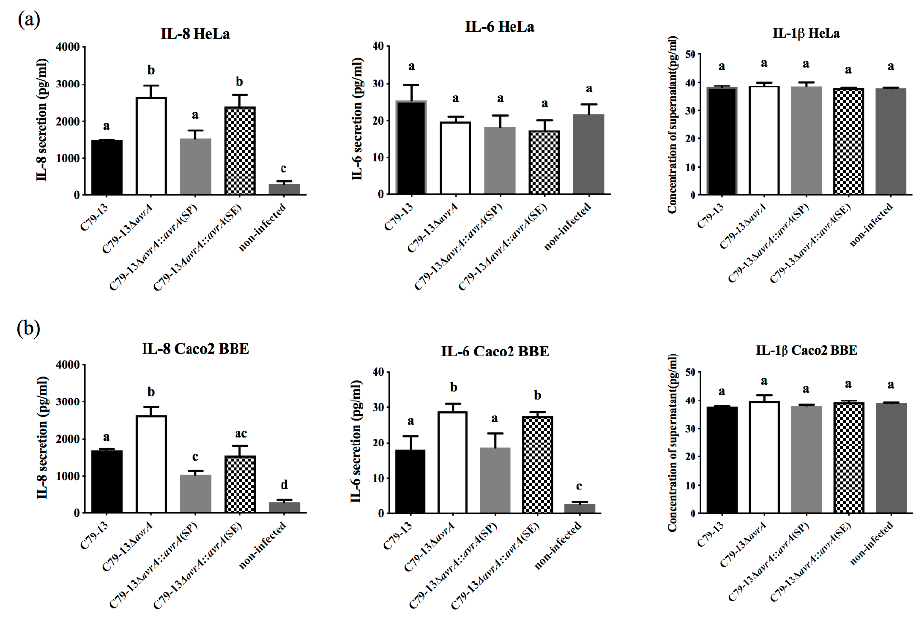
Figure 3. SP-AvrA suppresses IL-8 secretion in S. Pullorum C79-13-infected cells to a greater extent than does SE-AvrA. Secretion of IL-8, IL-6, and IL-1 β was measured in HeLa ( a ) and Caco2 BBE cells ( b ) infected with S. Pullorum C79-13, ∆ avrA mutant, and two complementary strains using FACs according to the instruction of the Human Inflammatory Cytokines Kit (BD, Franklin Lakes Campus, NJ, USA). Data are expressed as the mean + SD. The different letters on the error bars indicate statistically significant differences ( p < 0.05).